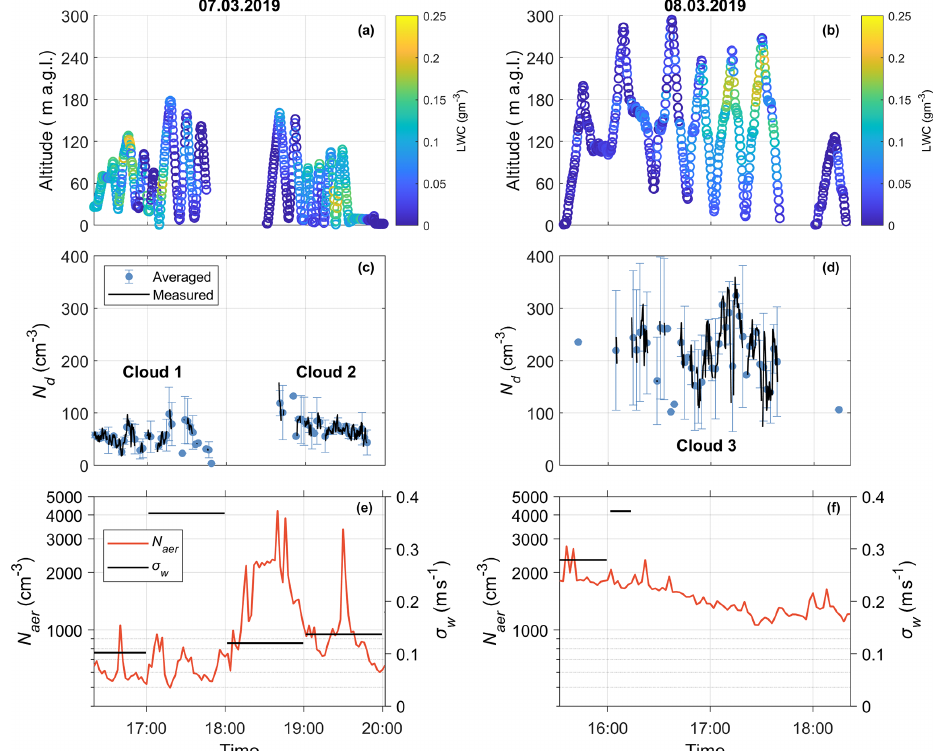
Figure 5. Time series of 7 March (a, c, e) and 8 March (b, d, f) showing the vertical profiles of the LWC (gm − 3 ) in panels (a) and (b) , the filtered (black lines) and the 2min averaged (cyan circles) N d (cm − 3 ) measured at WOP with the HoloBalloon platform in panels (c) and (d) , and the corresponding SMPS aerosol concentrations (cm − 3 ) (orange line) and the hourly wind lidar derived σ w values (ms − 1 ) (black line) in panels (e) and (f) . Error bars represent the standard deviation of N d during the averaging